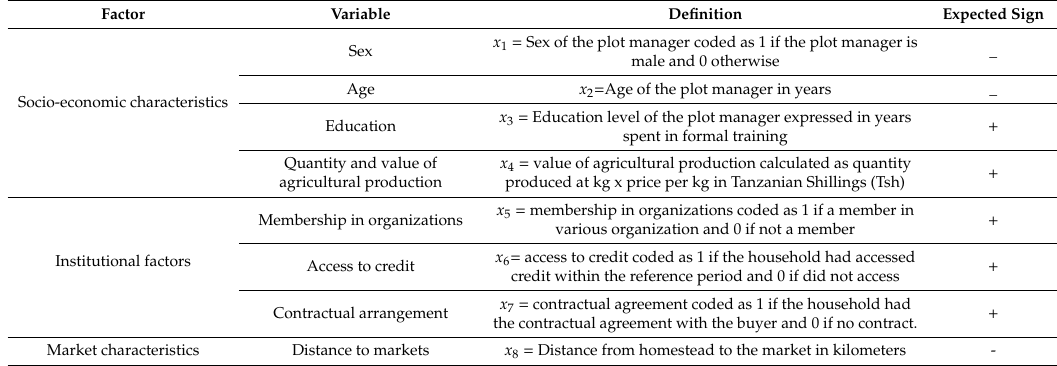
Table1. Marketcharacteristics, socio-economic, andinstitutionalfactorsforthemultinomiallogitmodel. Factor Variable